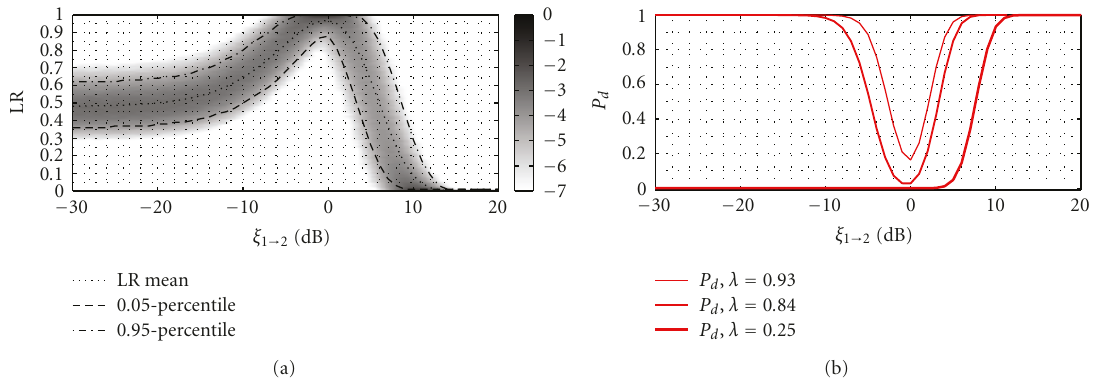
Figure 9: (a) Distributions of the LR for ξ 1 = 10 dB. The gray scale represents the natural logarithm of the measured relative frequencies of the LR values. The variance of the histograms is high during the decrease of the LR mean (dotted line). (b) Detection probabilities for three-decision thresholds λ as a function of the observed SNR change ξ 1 → 2 .